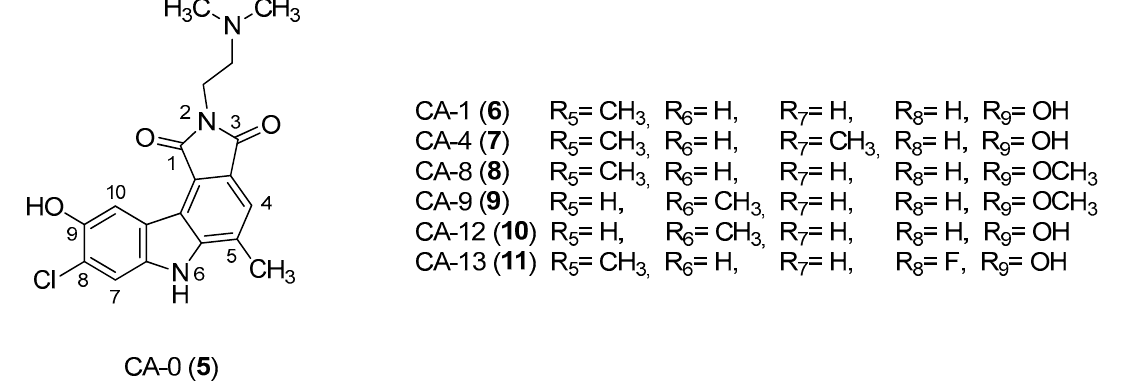
Figure 3. Structures of 8-chloro-2-[2-(dimethylamino)ethyl]-9-hydroxy-5-methylpyrrolo[3,4-c]carbazole-1,3(2 H ,6 H )-dione ( 5 ) and derivatives 6–11 .